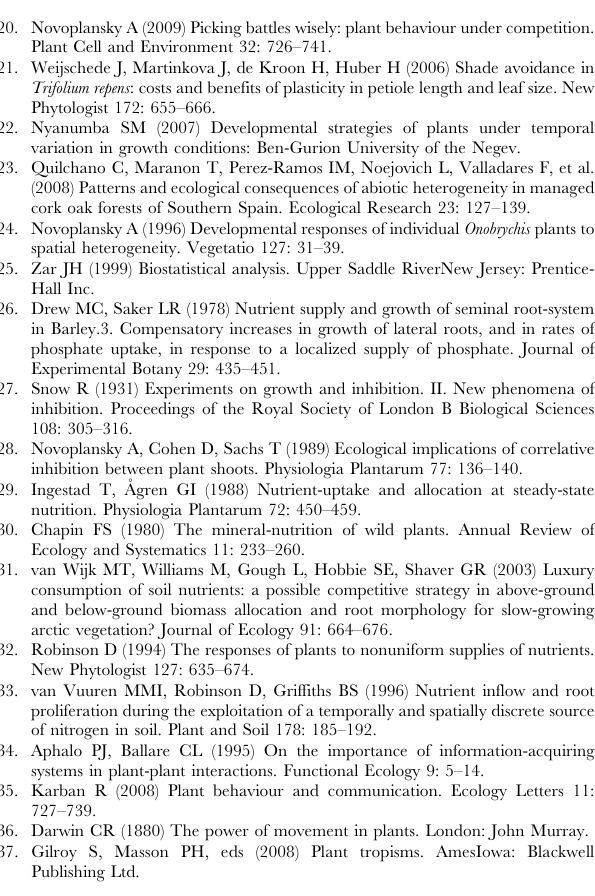
Figure S1 Total root biomass in the interim (a) and final (b) harvests. Nutrient regimes: INC (I), DEC (D), HIGH (H), AVE (A), LOW (L). Values are means 6 1 S.E. Found at: doi:10.1371/journal.pone.0010824.s004 (0.43 MB TIF) Figure S2 Vegetative shoot biomass in the interim (a) and final (b) harvests. Nutrient regimes: INC (I), DEC (D), HIGH (H), AVE (A), LOW (L). Letters indicate significant differences (Tukey), Bars lacking letters do not differ from any other bar. Values are means 6 1 S.E. Found at: doi:10.1371/journal.pone.0010824.s005 (0.44 MB TIF)